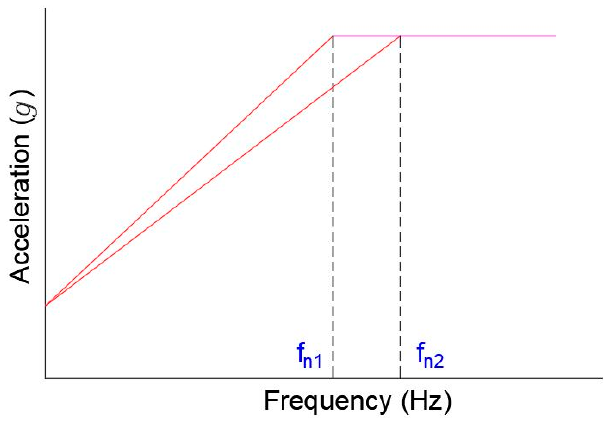
Figure 5. Knee frequency change in SRS.